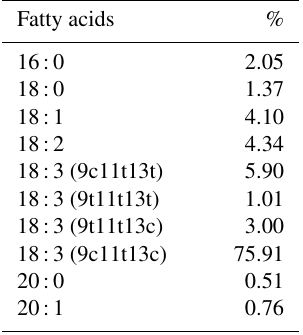
Table 1. Fatty acid composition of pomegranate seed oil (%).